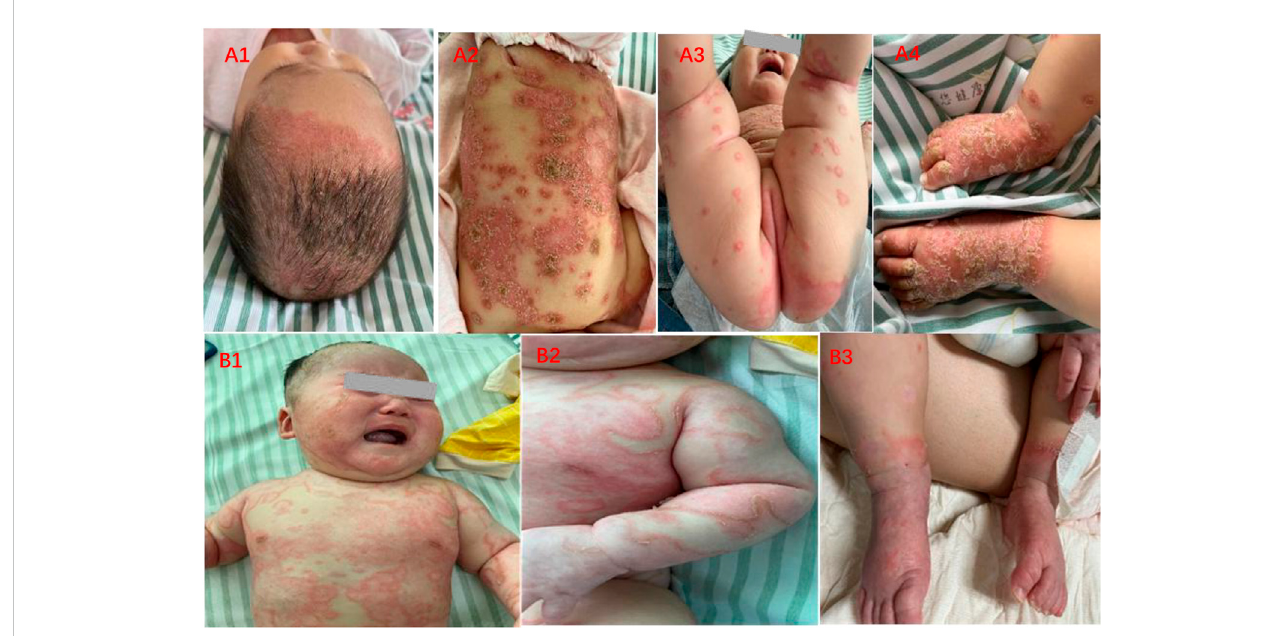
FIGURE 1 ClinicalfeaturesofIPPbeforeandaftertreatment. (A1 – A4) Widespreaderythema,coveredthickyellowishscales,andcirculardistributedpustulesonthe scalp, trunk, perineum, and extremities. (B1 – B3) Pink macules with subtle white scales scattered over body, pustules are nearly invisible.